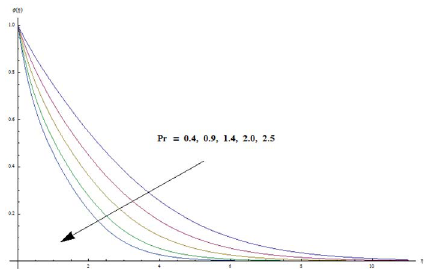
Figure 10. Variation in dimensionless concentration w ( g ) vs g for different values of Pr when l 1 ~ 0 : 3, b ~ 0 : 2, M ~ 0 : 5,